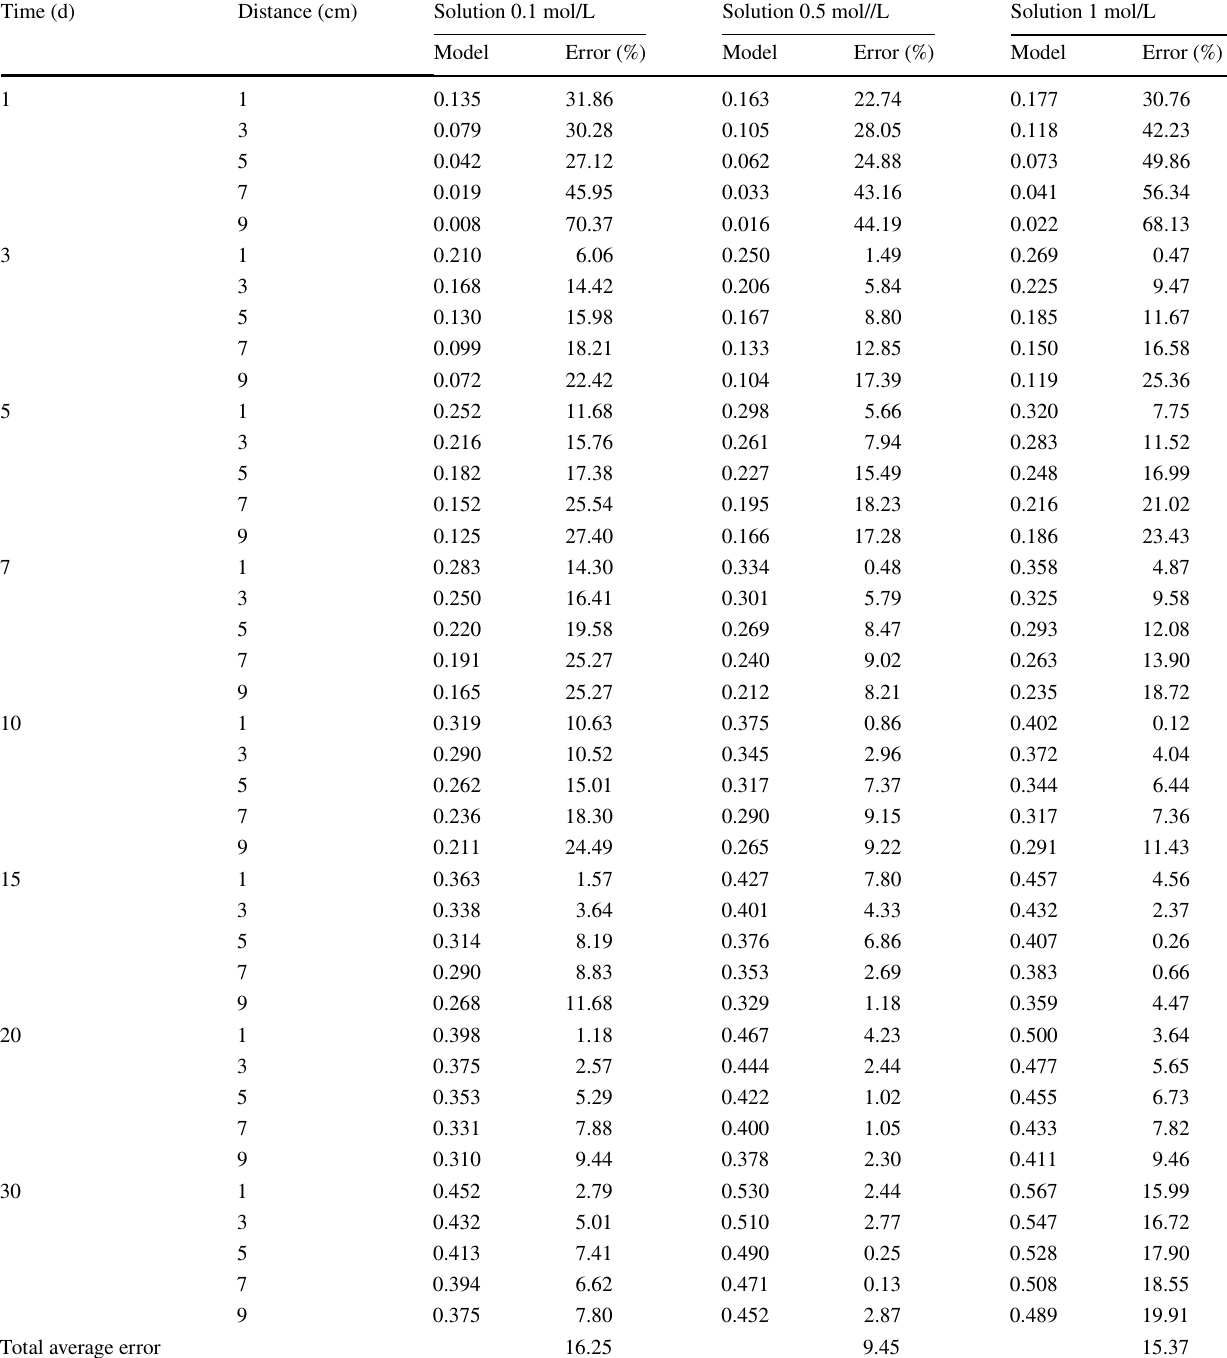
Table 3 Concentration of sulfate ions from the analytical model and errors Time (d) Distance